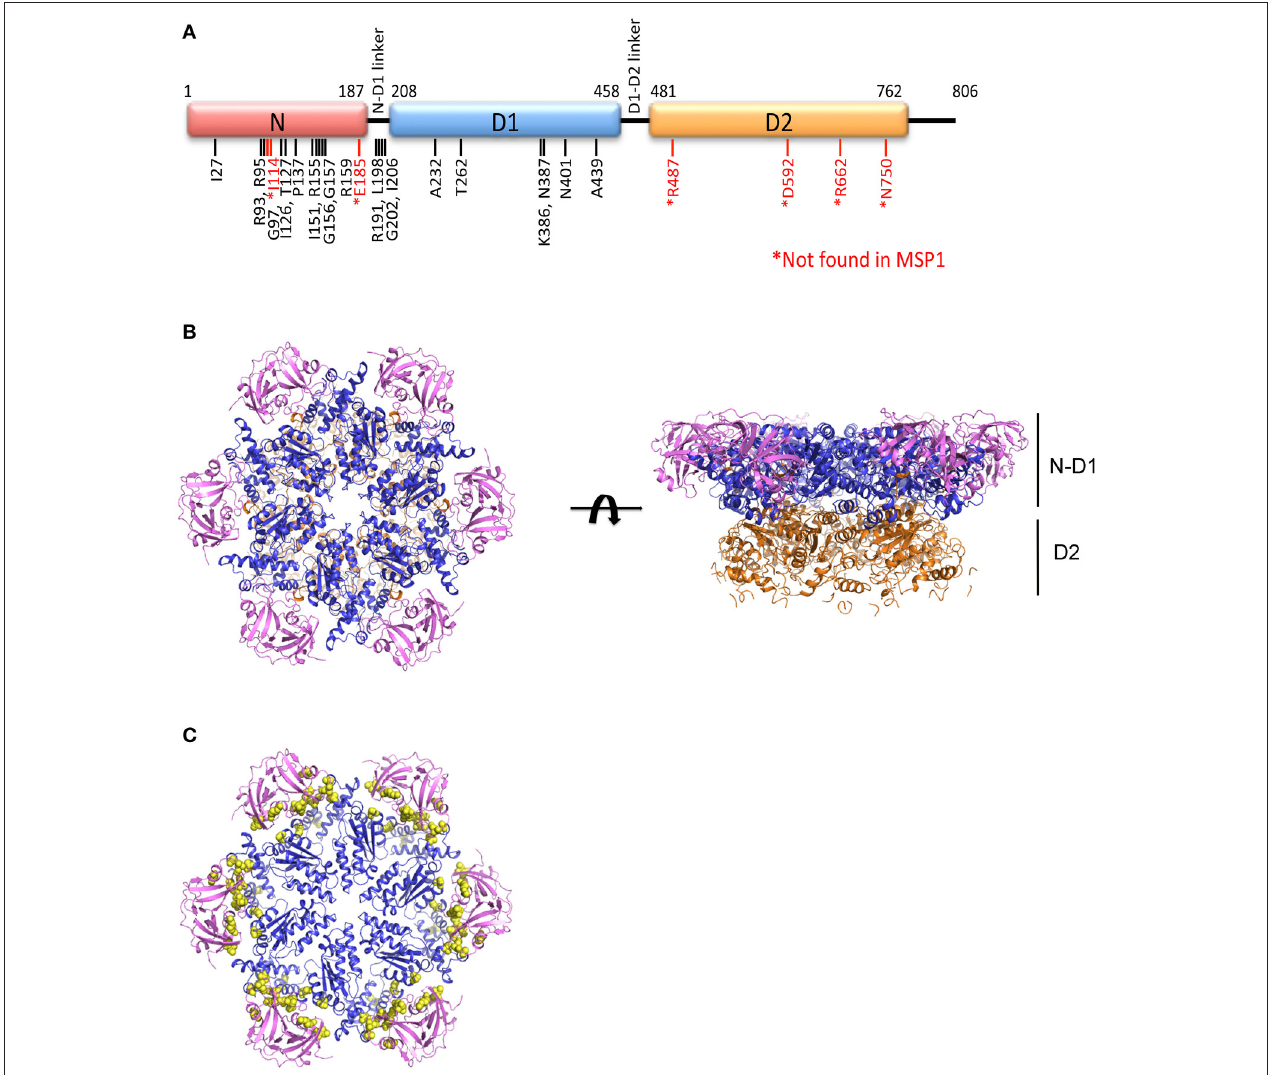
FIGURE 1 | Structure of the AAA ATPase p97. (A) Schematic domain organization of a p97 subunit showing the three structural domains: N-terminal N domain and two ATPase domains D1 and D2, and the positions of pathogenic mutations. (B) Ribbon representation of the top and side views of the hexameric structure of FL p97 (PDB:3CF2, Davies et al., 2008). The N domain is in purple, D1 domain in blue and D2 domain in gold. (C) The top view of ND1 p97 structure showing the location of pathogenic mutations. Selected pathogenic mutations (residue I27, R93, I126, P137, R155, R191, L198, I206, A232, T262, N387, N401, A439) are represented as yellow spheres on the ribbon diagram of ND1 p97 with ADP bound (PDB: 1E32, Zhang et al.,